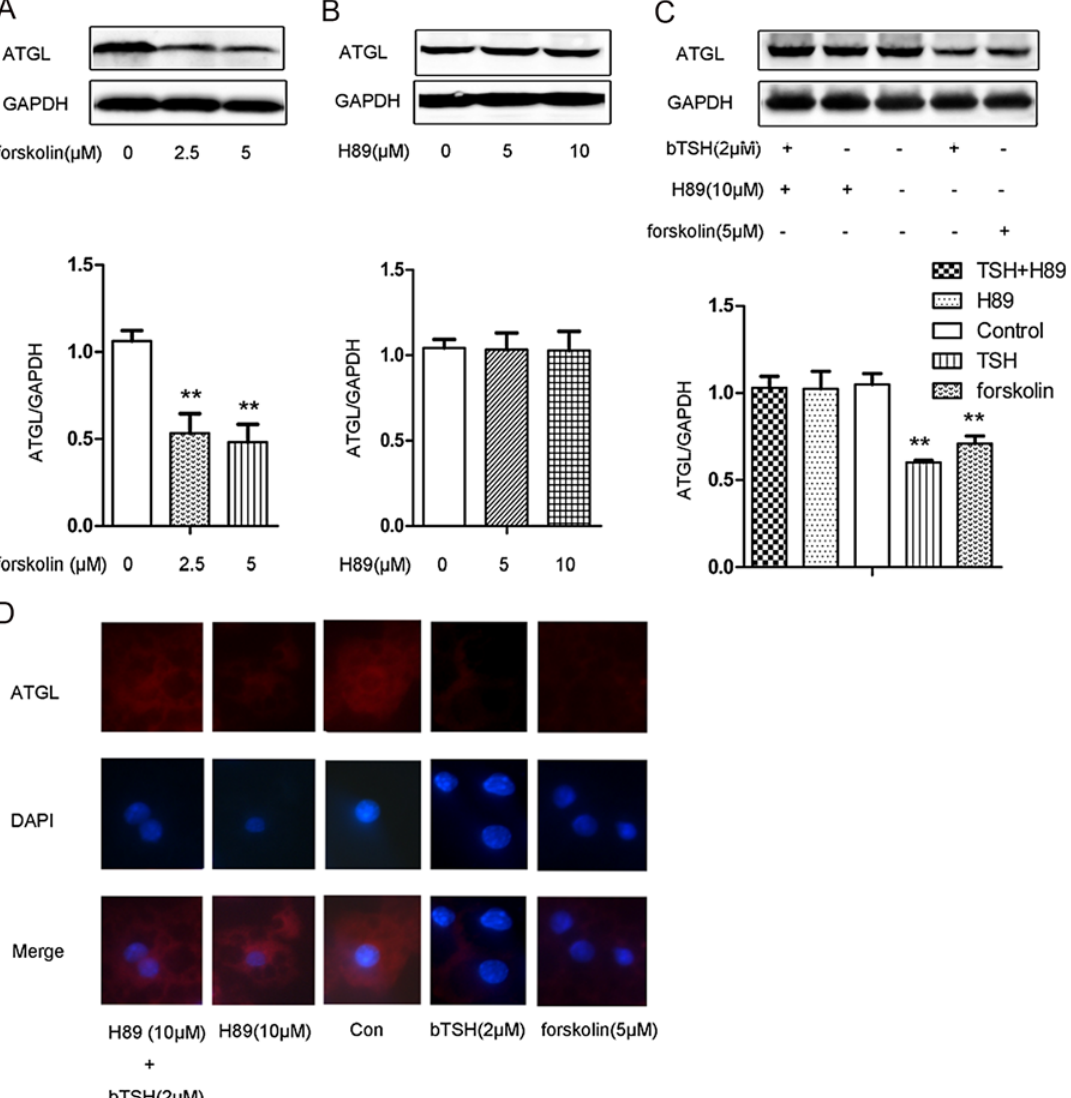
Figure 4. cAMP/PKA involved in TSH-induced downregulation of ATGL expression in differentiated 3T3-L1 cells. (A) On D12, cells were treated with 2.5 μ M forskolin, 5 μ M forskolin, or vehicle, respectively, for 24 h in serum-free DMEM. (B) On D12, the cells were stimulated with 5 μ M H89, 10 μ M H89 or vehicle, respectively, for 24 h in serum-free DMEM. (C) On D12, the cells were stimulated with 5 μ M forskolin, 10 μ M H89 or 2 μ M bTSH. After 1 h, the cells from one of the two dishes pretreated with 10 μ mol/L H89 were exposed to 2 μ M bTSH. All cells were treated for 24 h in serum-free DMEM. Proteins were separated by SDS-PAGE and immunoblotted for ATGL and GAPDH, as indicated. Representative Western blot results are shown. (D) The visualization of ATGL by immunofluorescence staining (red). Nuclei were stained with DAPI (blue). Values are reported as the fold change relative to the control group. The data are presented as the mean (cid:2) SD. ** p < 0.01 versus the control group. Original magnification: 400